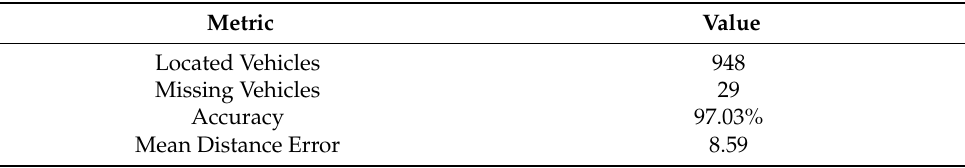
Table 1. Evaluation metrics for vehicle localization.